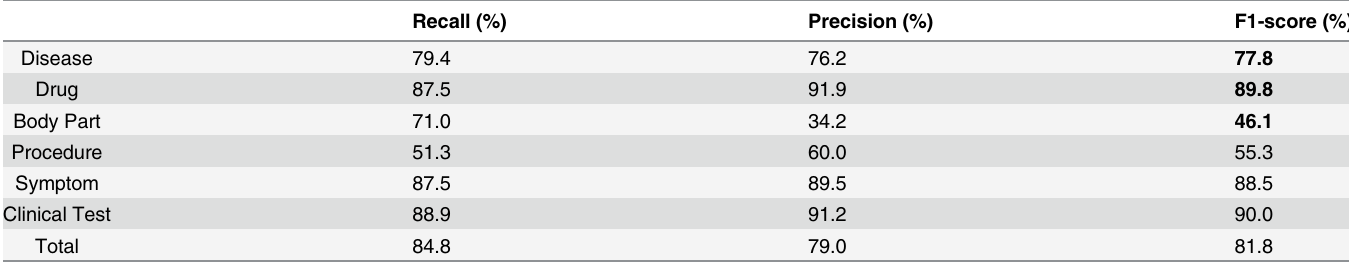
Table 2. Term recognition after pattern iteration.